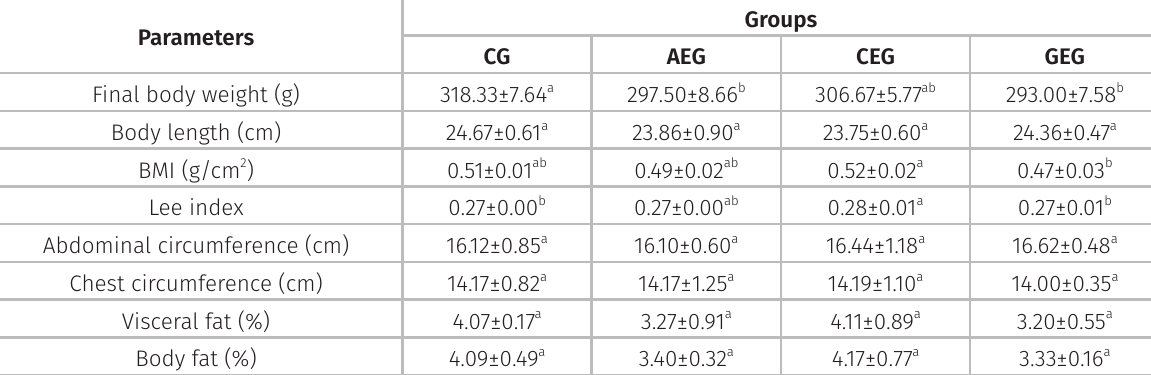
Figure 2. Food intake (a) and weight gain (b) of rats supplemented or not with acerola, cashew, or guava by- products. a,b Different lowercase letters in vertical bars indicate a significant difference between the mean ± standard deviation of each rat group (one-way ANOVA, P ≤ 0.05, Tukey’s Post hoc test; n = 8 rats/group). CG = control group; AEG= acerola by-product experimental group; CEG = cashew by-product experimental group; GEG= guava by-product experimental group. Table II. Murinometric parameters, quantification of visceral and body fats of Wistar rats supplemented or not with acerola, cashew or guava